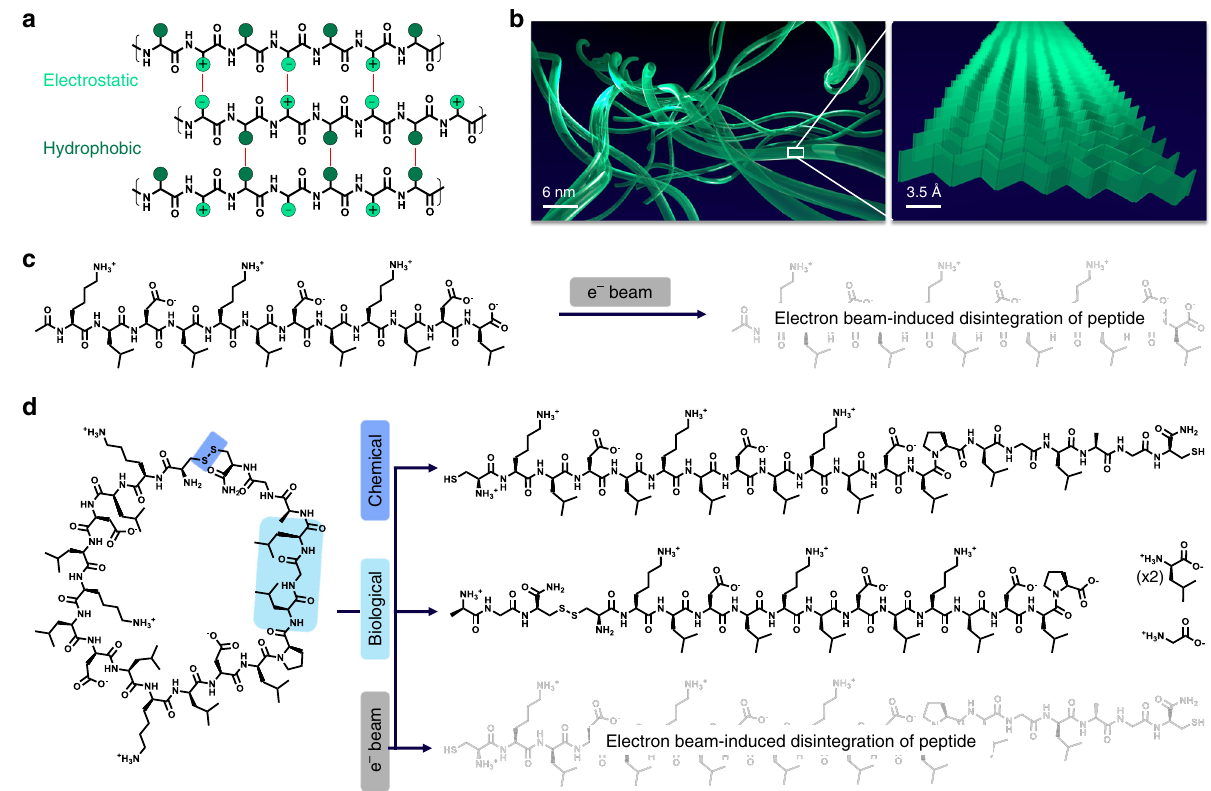
Fig. 2 Stimuli-responsive peptides. a Self-assembly through electrostatic (light green) and hydrophobic (dark green) interactions between peptide strands. b Peptides stack as β -sheets that further assemble as fi brils. c KLDL peptide and hypothetical electron beam damage product. d cycKLDL with built-in stimuli-responsive sites and their products following chemical reduction of the disul fi de bond, biological cleavage by enzymatic activity, and